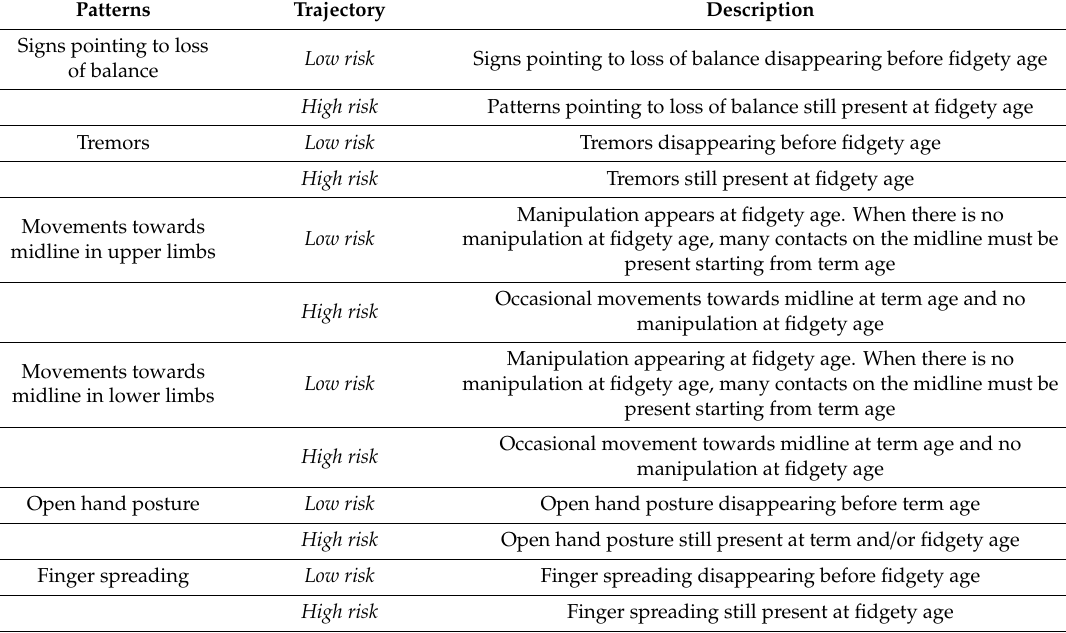
Table 2. Concomitant motor and postural patterns’